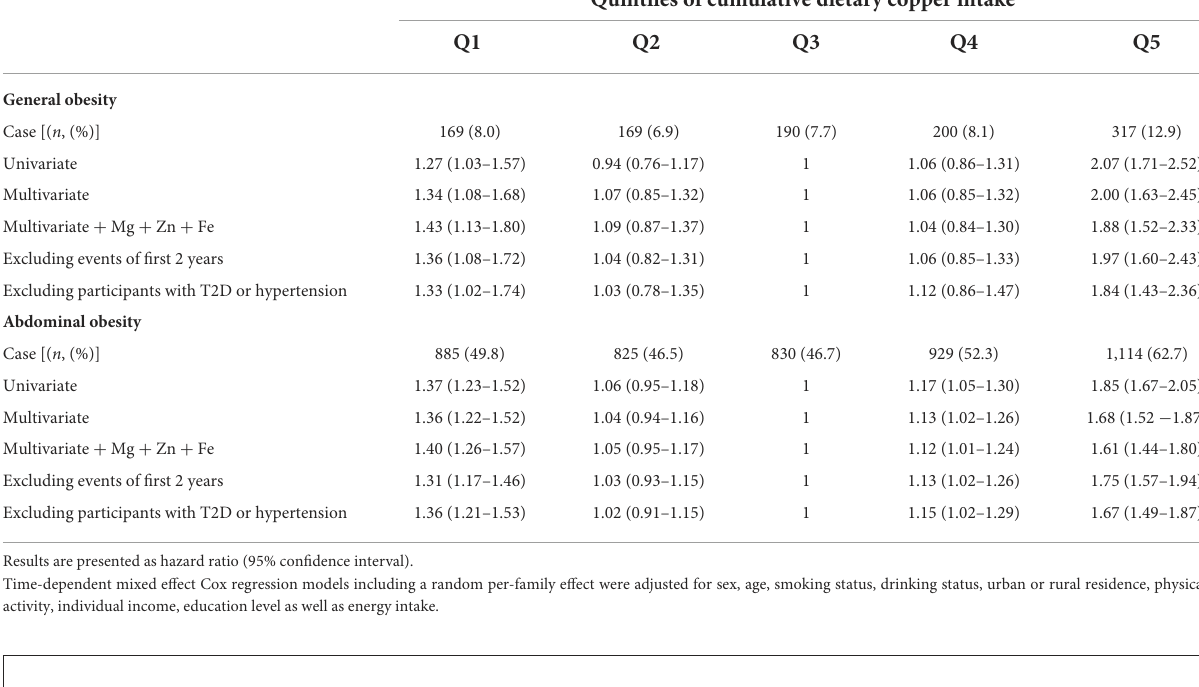
TABLE 2 Association of cumulative dietary copper intake with general obesity and abdominal obesity.